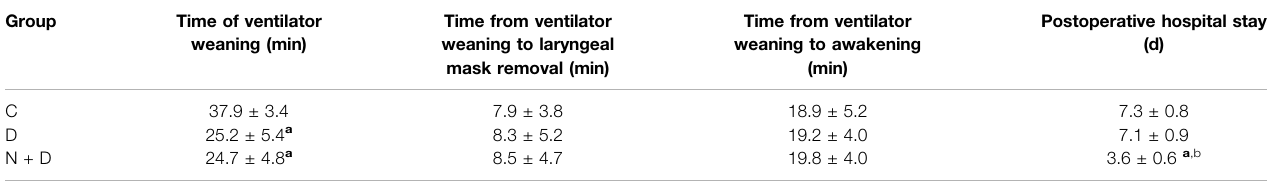
TABLE 6 | Comparison of ventilator weaning, laryngeal mask removal, awakening time, and postoperative hospital stay among groups ( (cid:1) x ±s ).